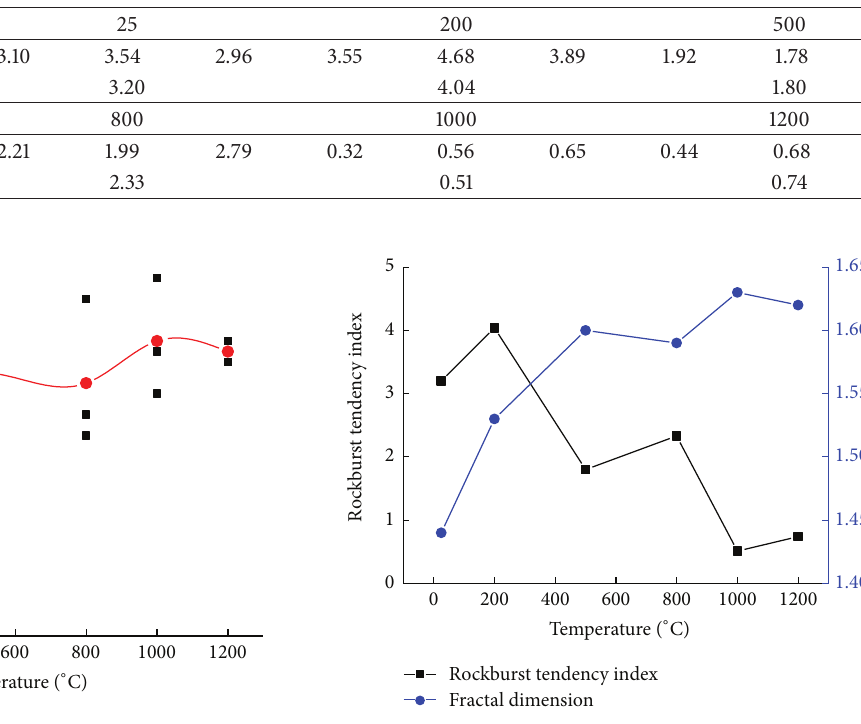
Figure 5: Relationship between the rockburst tendency index and